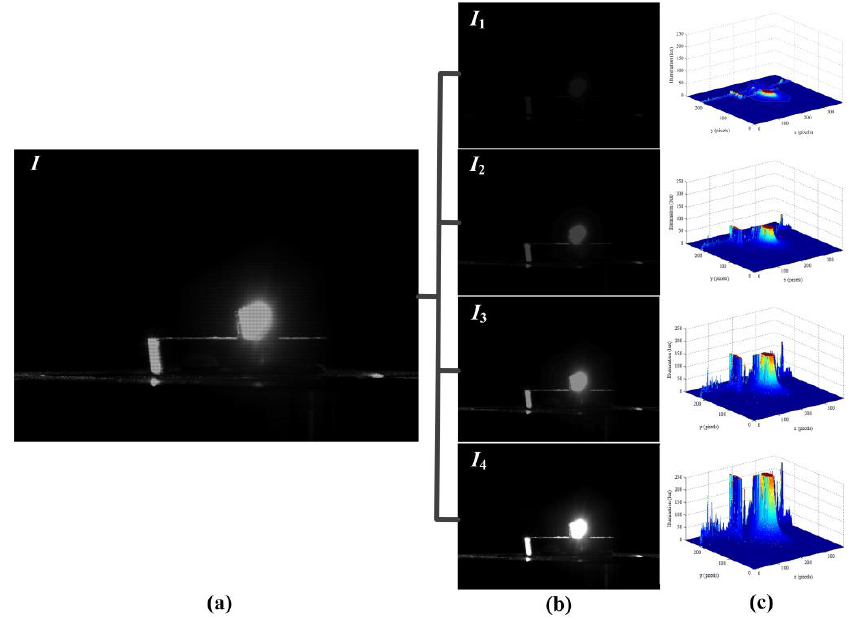
Figure 9. The first example result of coded exposure for the brightness changes of candle